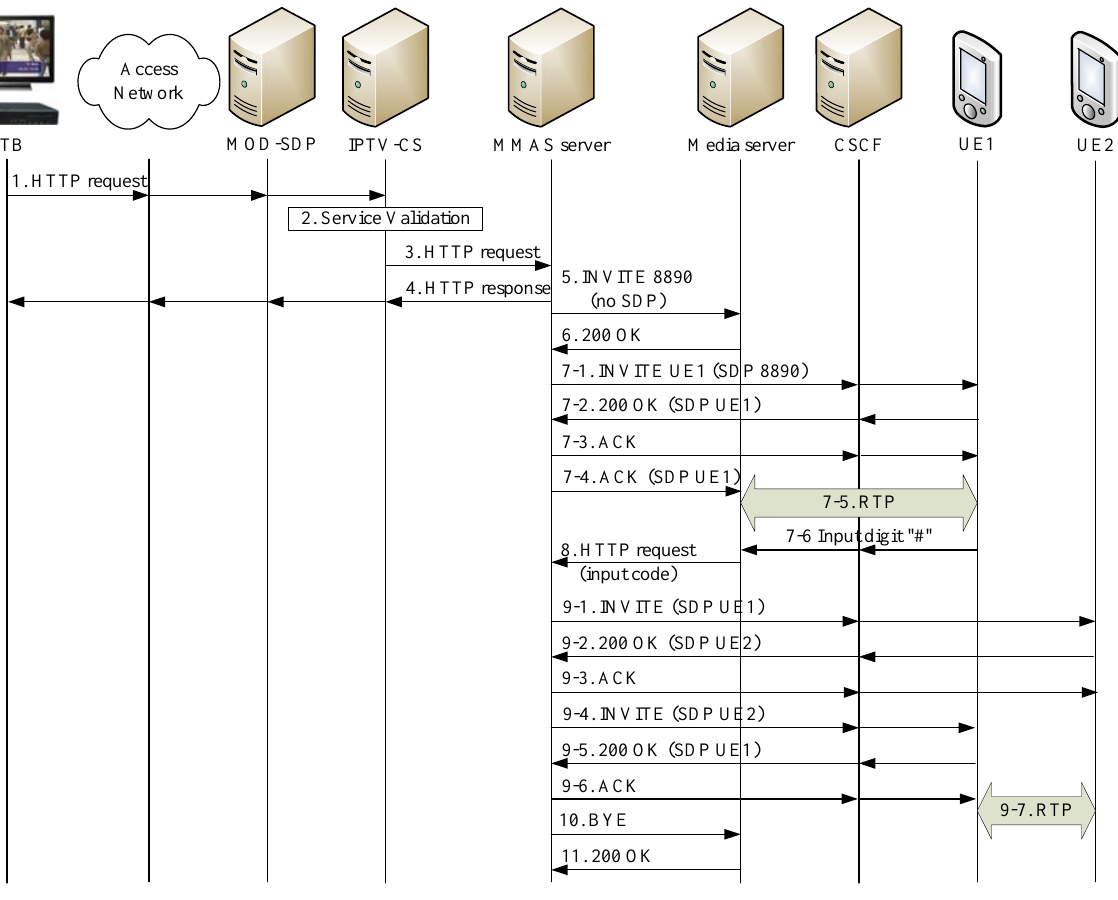
Figure 8. Message flow for TV shopping/food